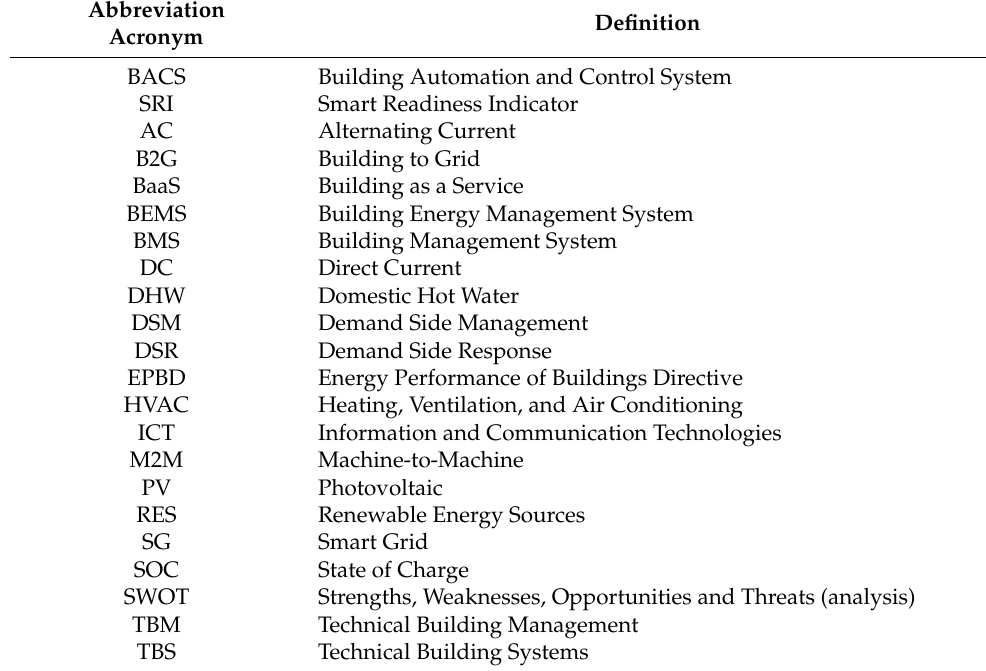
Table 1. Abbreviations and acronyms used within the paper (alphabetical